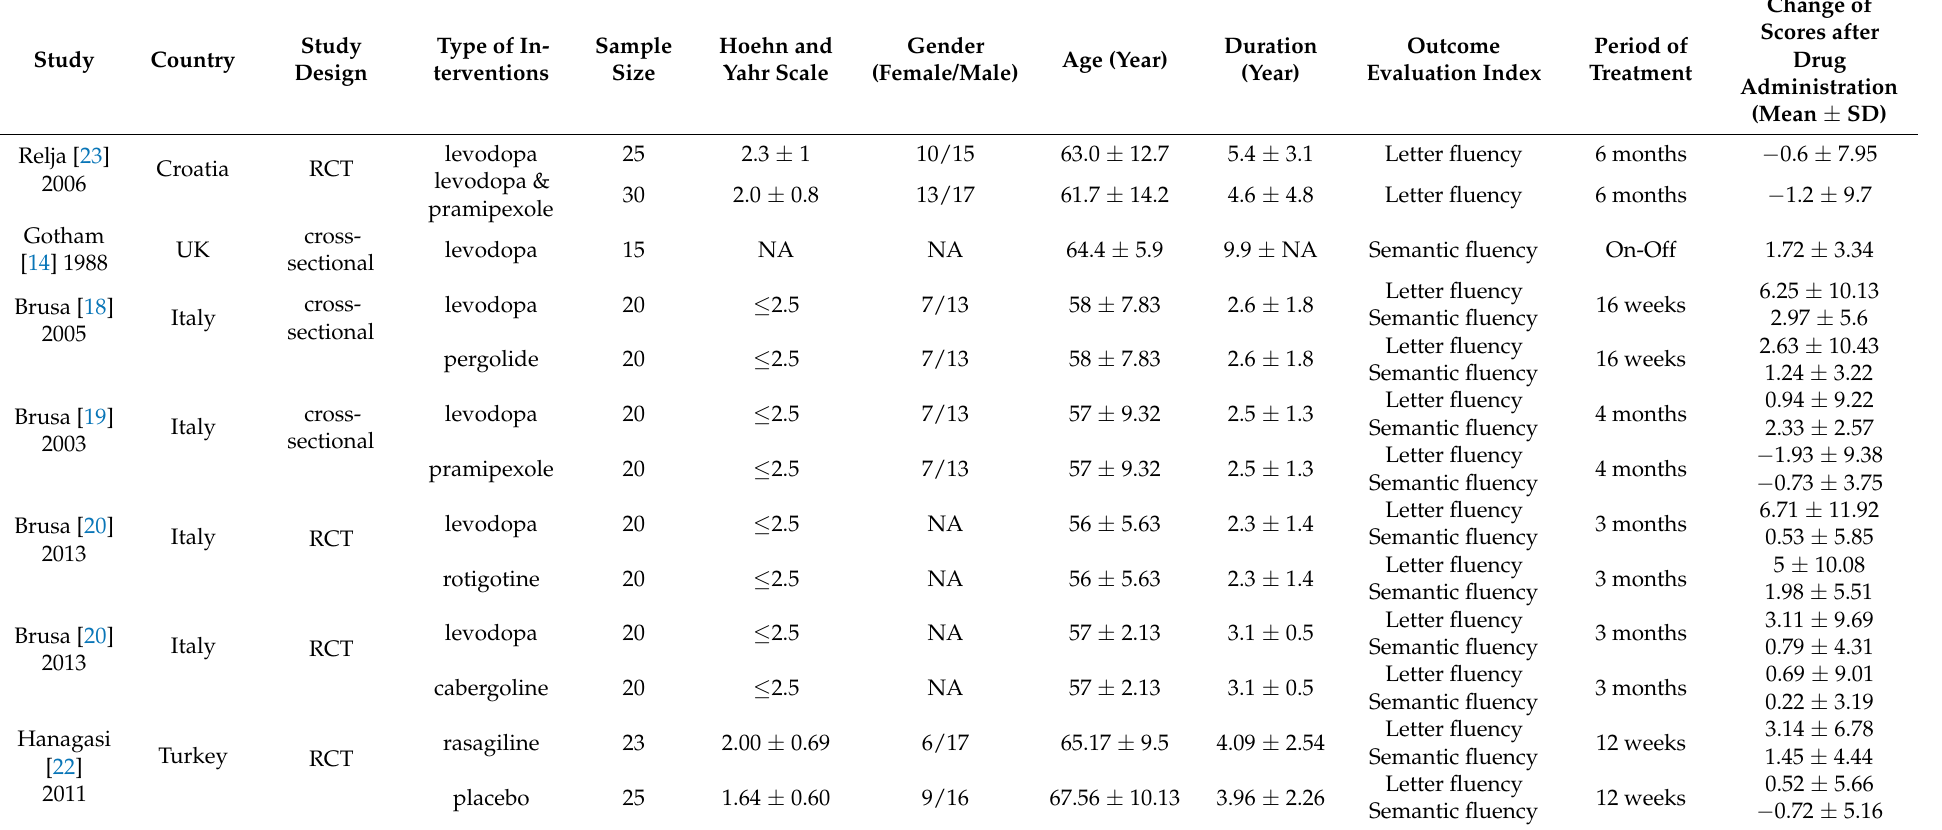
Table 1. Characteristics of included